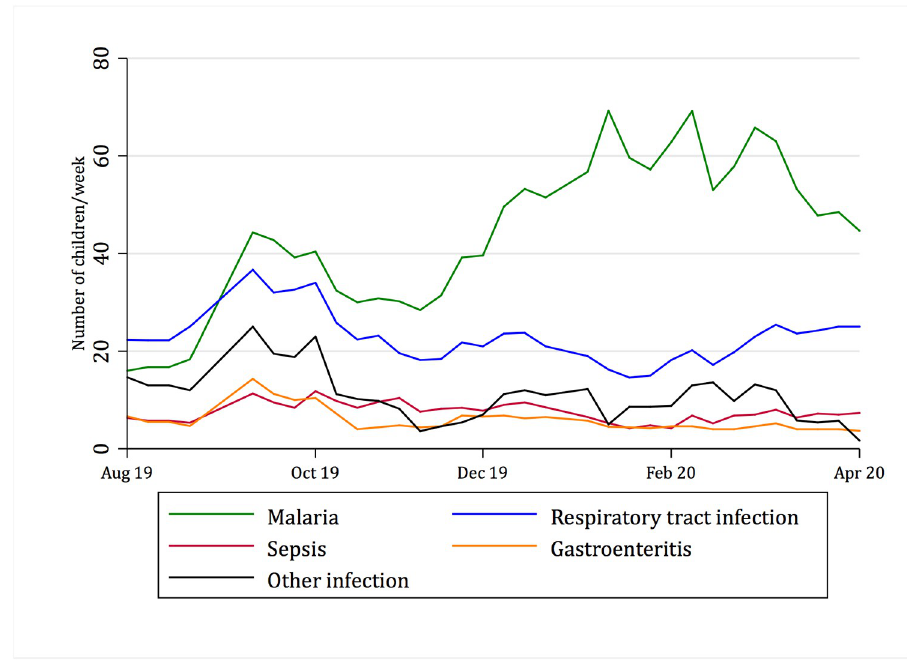
Fig 1. Seasonality of different infections by